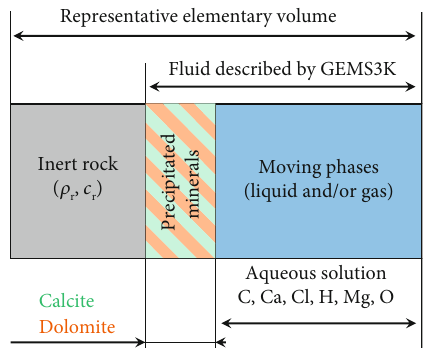
Figure 5: Sketch of the representative elementary volume. The fl uid, i.e., the moving phases and precipitated minerals, occupies the pore space. The rest of the volume is regarded as inert rock.